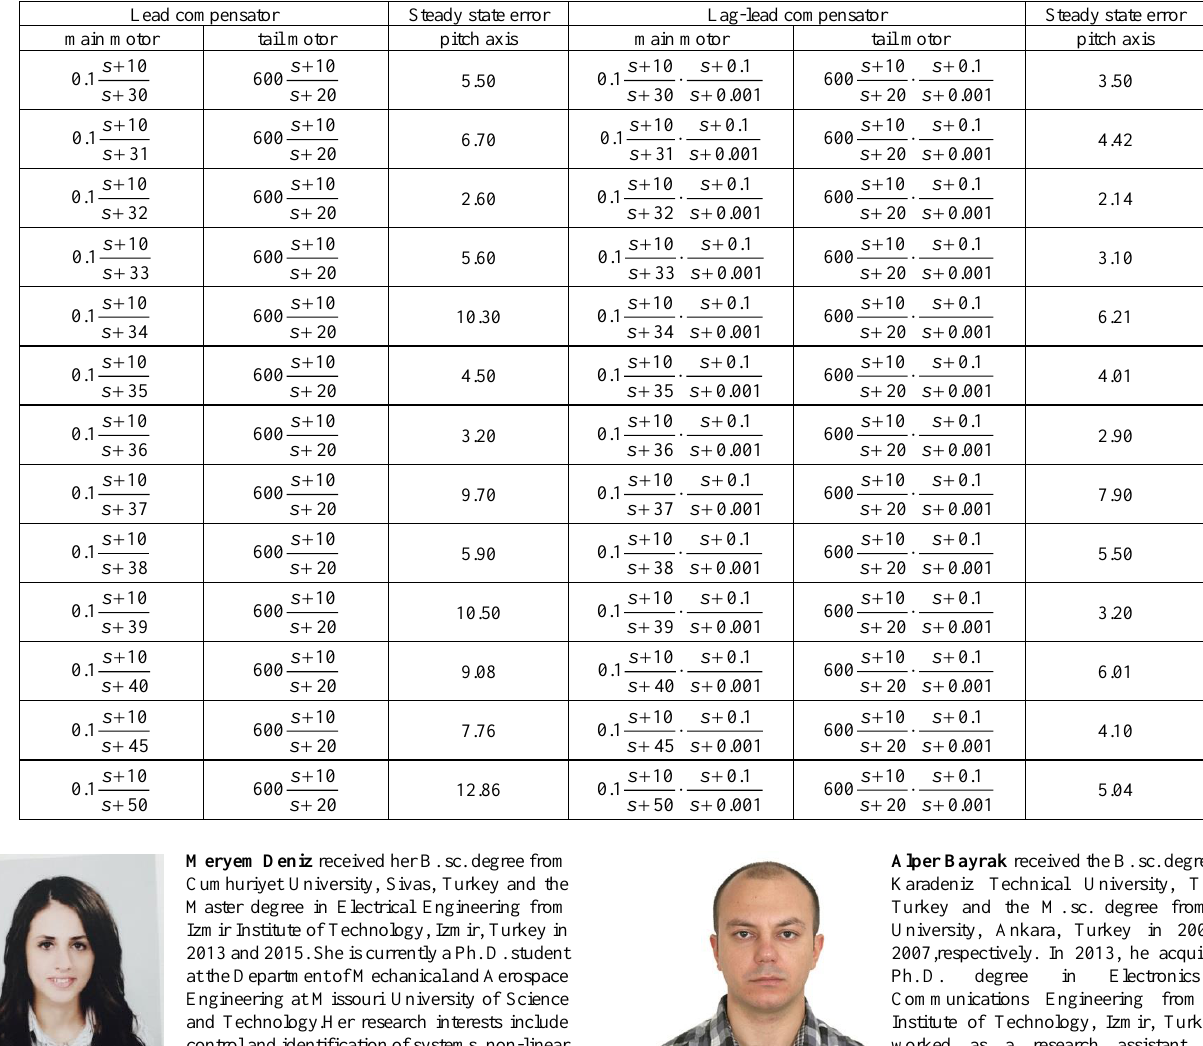
C OMPARISON OF S TEADY S TATE E RRORS OF A NGULAR P ITCH AND Y AW P OSITIONS FOR L AG -L EAD C OMPENSATORS C OMPARED W ITH L EAD C OMPENSATORS A PPLIED ON B OTH M